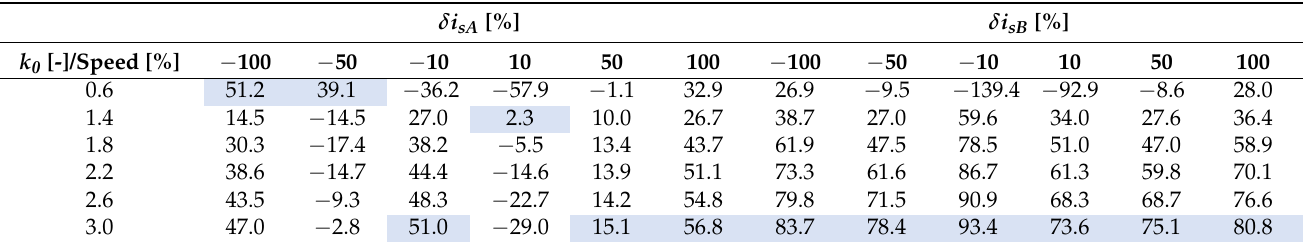
Table 4. Decrease in MLO sensitivity to changes in IM parameters relative to OLO, for a faulty CS in phase A (grey color indicates the best improvement).